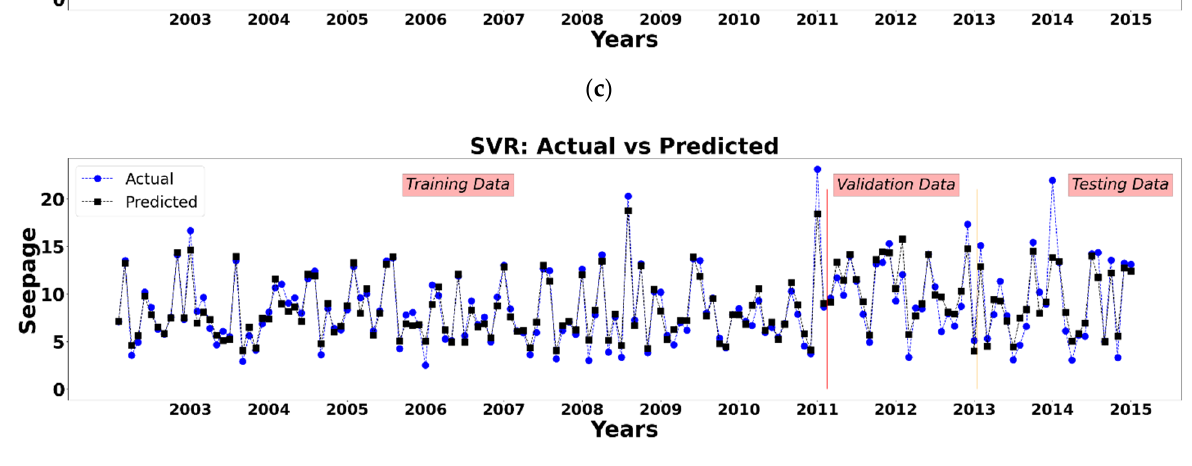
Figure 7. Actual vs. Predicted Average Seepage from Machine learning (ML) Models.